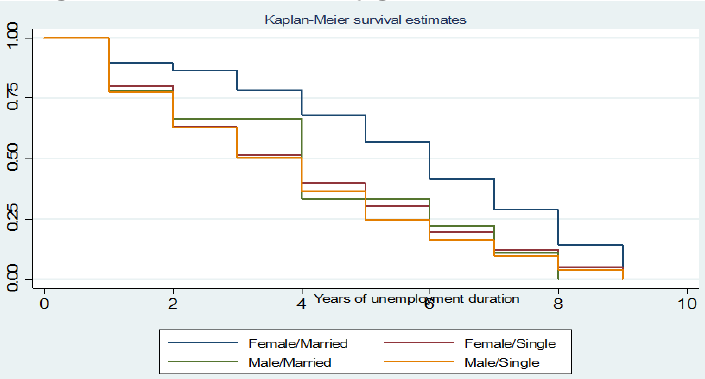
Figure 7: Survival function by gender and marital